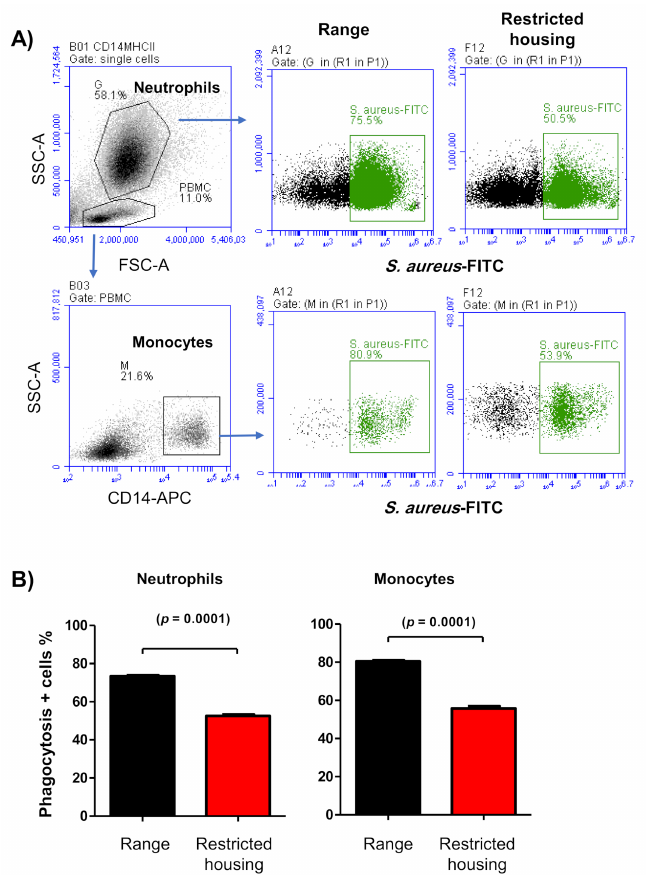
Figure 7. Bacterial phagocytosis by neutrophils and monocytes from free-range and housed camels. Camel leukocytes were labeled with antibodies to the monocyte marker CD14 and were then in- cubated with S. aureus conjugated with FITC. ( A ) Fow cytometric assessment of phagocytosis by neutrophils and monocytes. Neutrophils and monocytes were gated based on their SSC values and CD14 staining, respectively. In an SSC against FL-1 dot plot, the percentage of cells with positive green staining (FITC- s aureus ) was calculated and presented graphically ( B ) for free-range and housed animals as mean ± SEM ( t